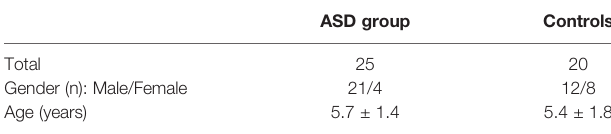
TABLE 1 | Characterization of participants in the study. ASD group